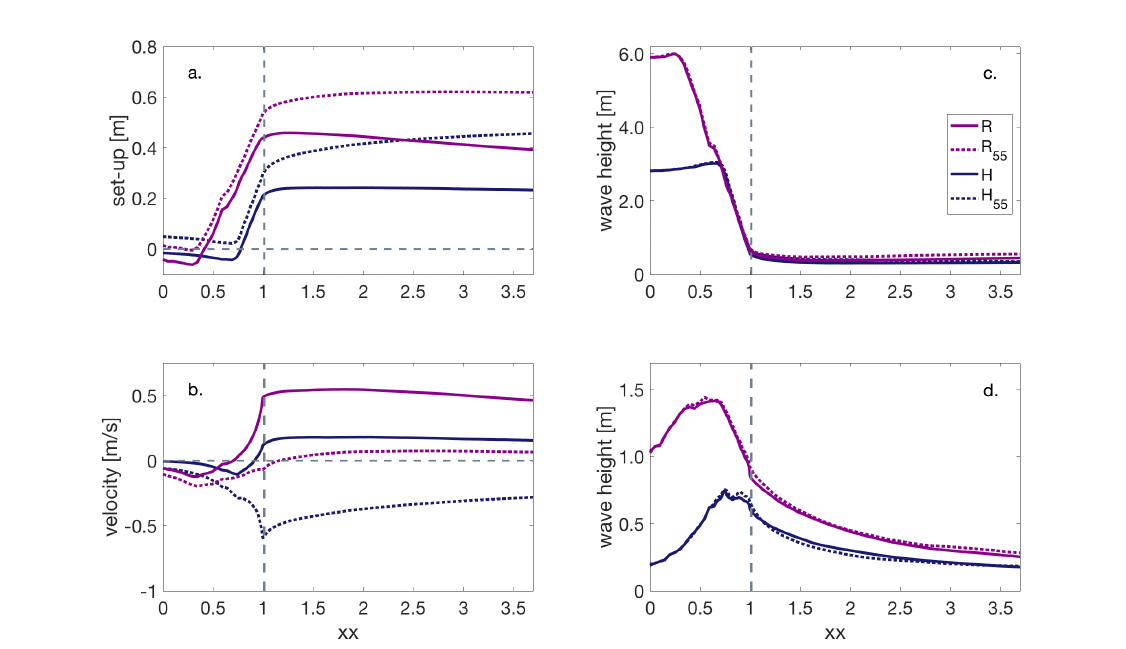
Figure 9. Predicted water level set-up (which includes higher water levels in the basin) ( a ), mean flow velocities ( b ), short- ( c ) and IG wave heights ( d ) for R , H , R 55 , and H 55 . The extension 55 refers to a water level that is 0.55 m higher in the back barrier basin. The x -axis is the normalized grid ( xx ) from the beginning of the seaward slopes ( xx = 0) to the back barrier basin ( xx = 3.7). Here, the slopes are the same (1:120) and output at all grid locations is in the same water depth. The vertical dashed line indicates the location of the